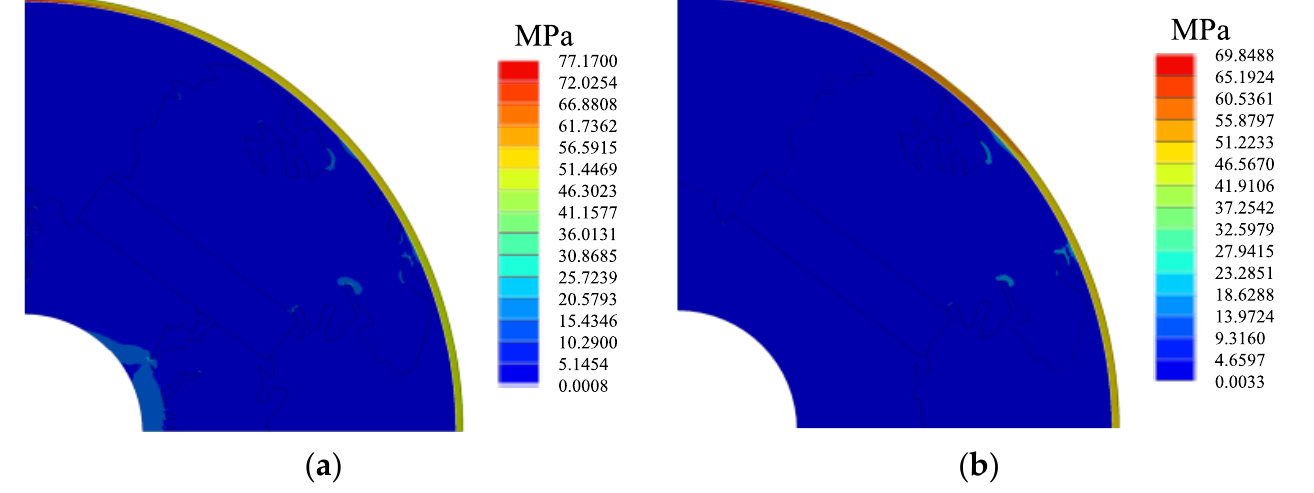
Figure 16. The von Mises stress distributions at 3600 rpm for topology-optimized AIPMSM rotors, ( a ) is distribution of the original selected model 0, and the maximum von Mises stress is 77.1700 MPa, and ( b ) is the distribution of the simplified model, and the maximum von Mises stress is 69.8488 MPa.